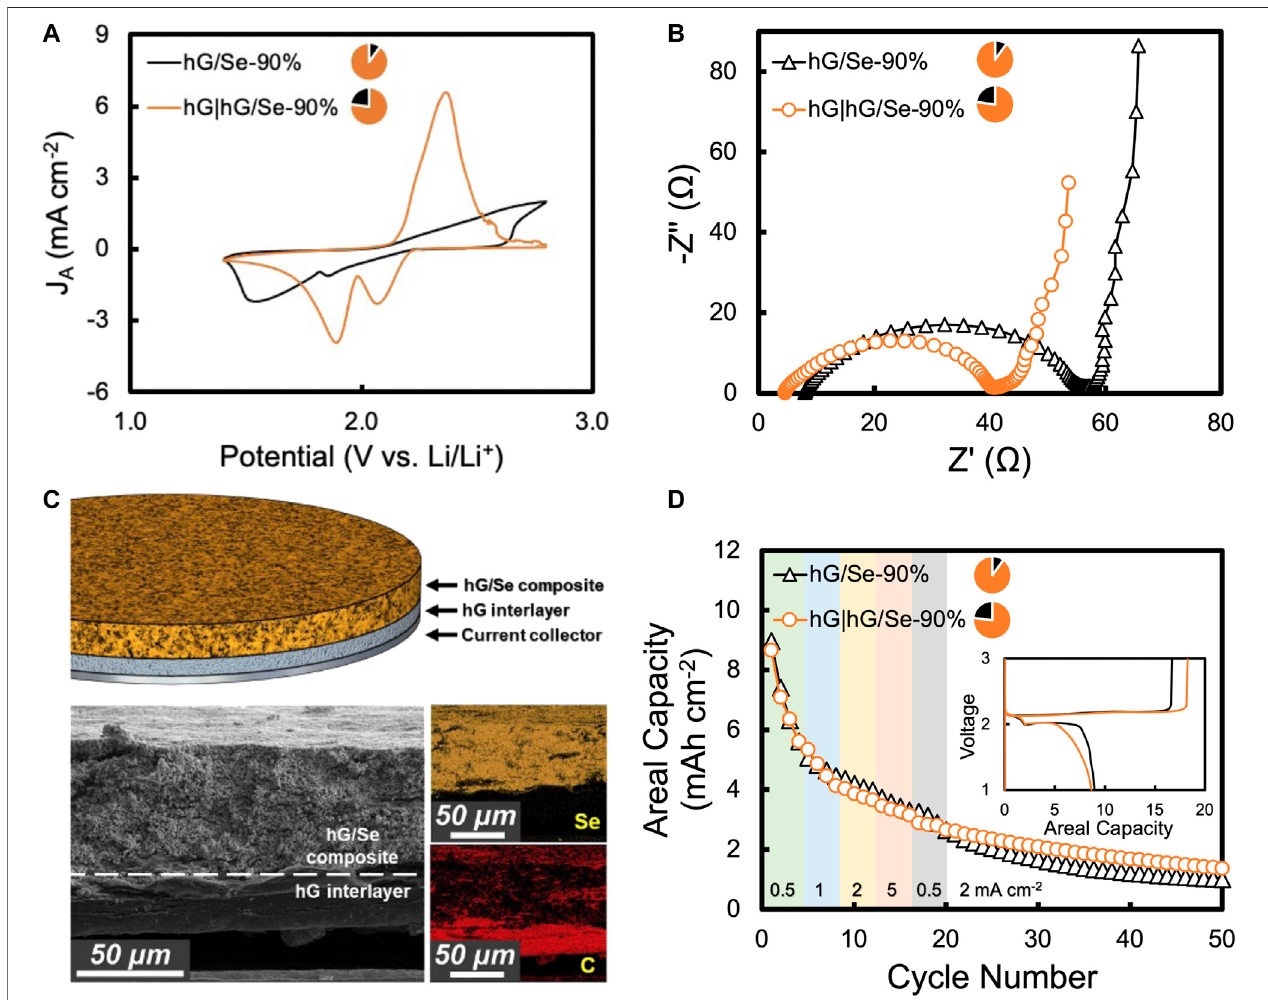
FIGURE 4 | hG/Se cathodes with a layered architecture, where a hG layer is inserted between the composite electrode and the current collector: (A) CV curve comparison and (B) Nyquist plot comparison from EIS measurements for battery cells with a hG/Se-90% cathode and a hG|hG/Se-90% cathode; (C) a schematic illustrationofthelayeredelectrodearchitectureandaSEMimagewiththecorrespondingSeandCmapsfromEDS; (D) cyclingperformancecomparisonofthetwocells; insetshowsthe discharge – chargecurves ofthe fi rst cycle.Batterieswere sequentially cycledat 0.5, 1, 2,and 5 mA cm − 2 ,each for4 cycles, then at 2 mA cm − 2 . In (A, B, D) , curves for the hG/Se-90% electrode and the hG|hG/Se-90% are black and orange colored, respectively.